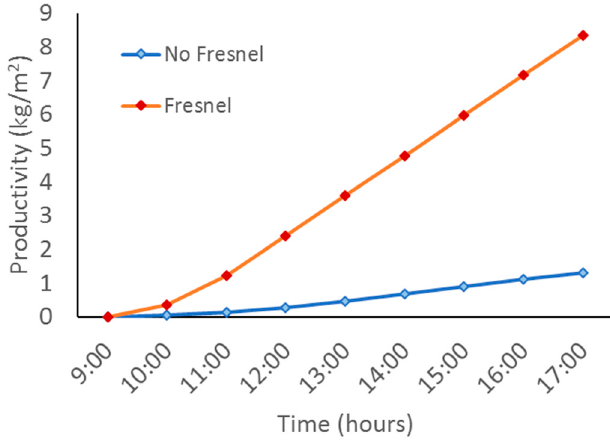
Figure 5. Cumulative water productivity.